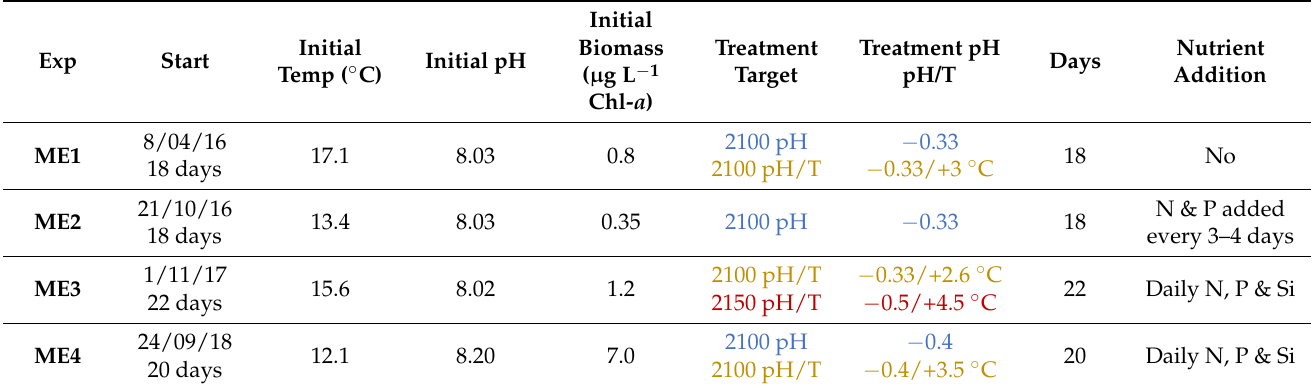
Table 1. CARIM Mesocosm parameters with the target values for 2100 low pH treatment in blue, 2100 pH/T in dark yellow and dark red for 2150 pH/T